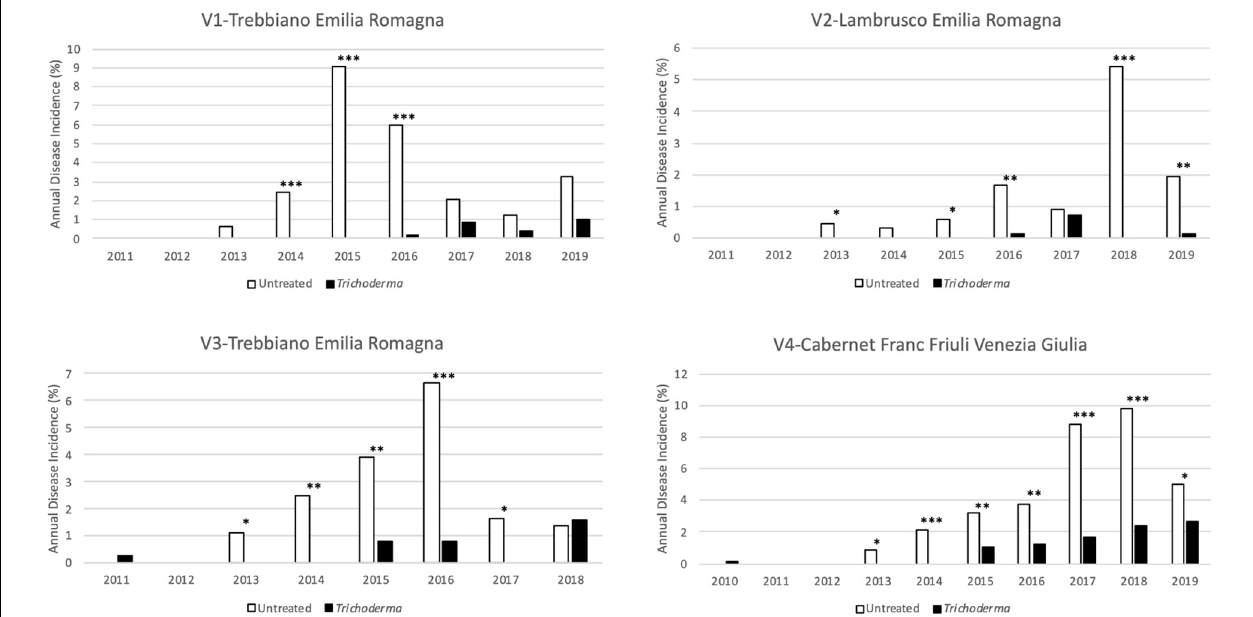
FIGURE 3 | Annual disease incidence in the four young asymptomatic vineyards monitored for 8–10 years. Data were analyzed by χ 2 test. All the plants of each plot were considered to compare Trichoderma and control treatments. Where differences in distribution between the two treatments were significant, asterisks were placed ( ∗ P < 0.05, ∗∗ P < 0.01, and ∗∗∗ P < 0.001 significance levels, respectively).